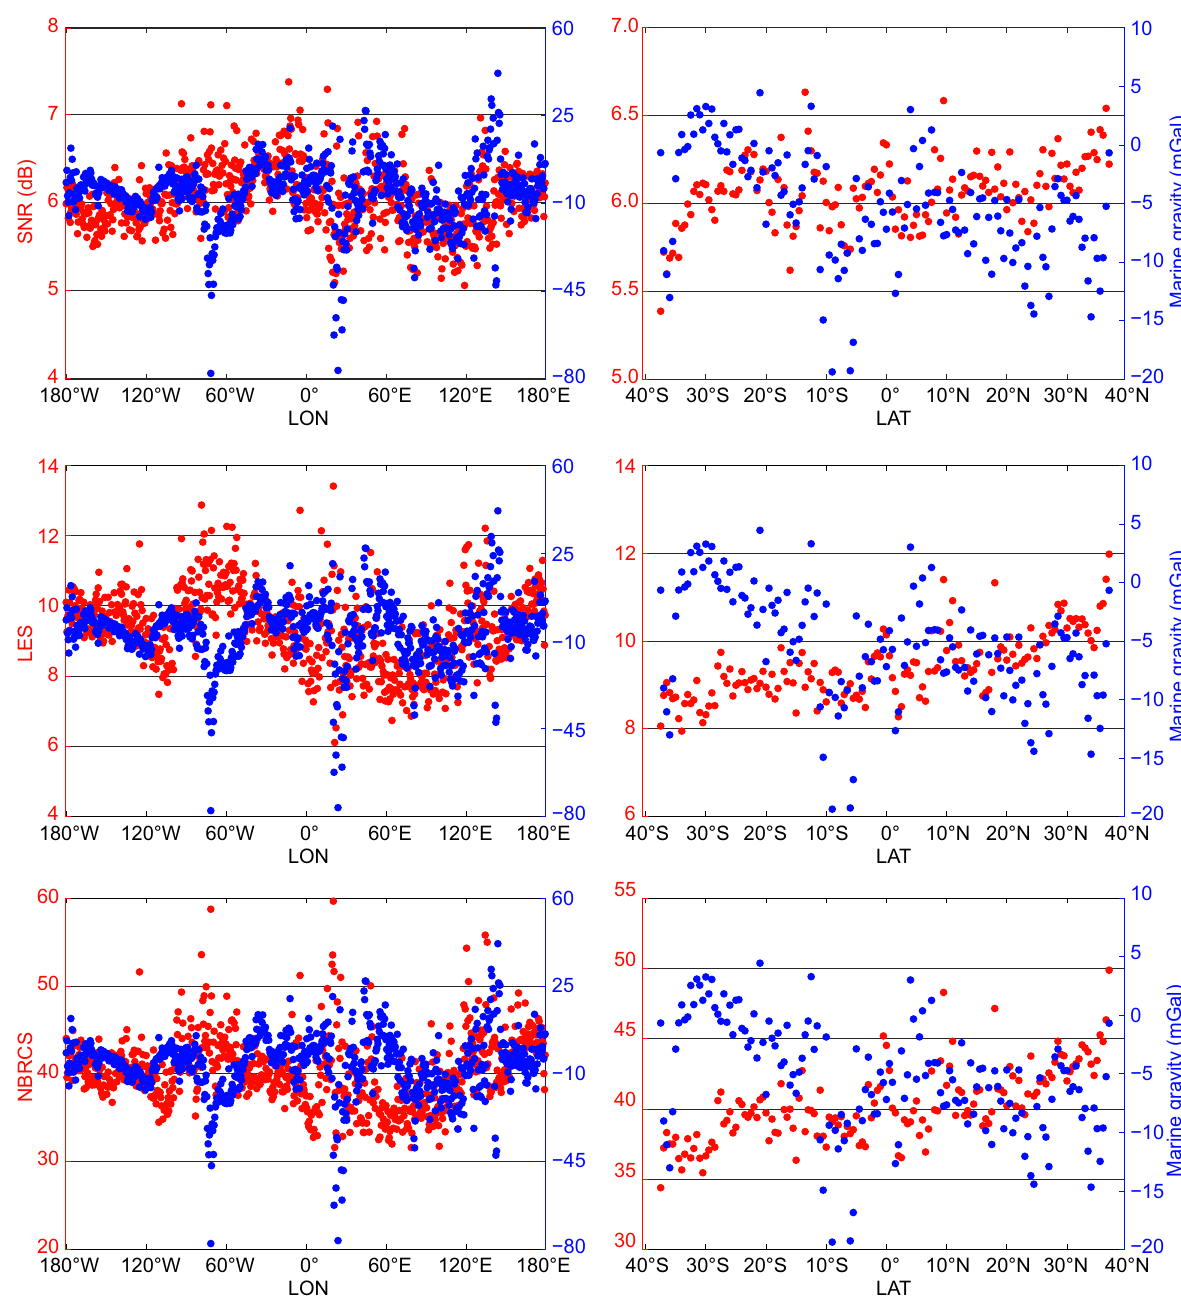
Fig. 3 The comparison between marine gravity and CYGNSS observables in different